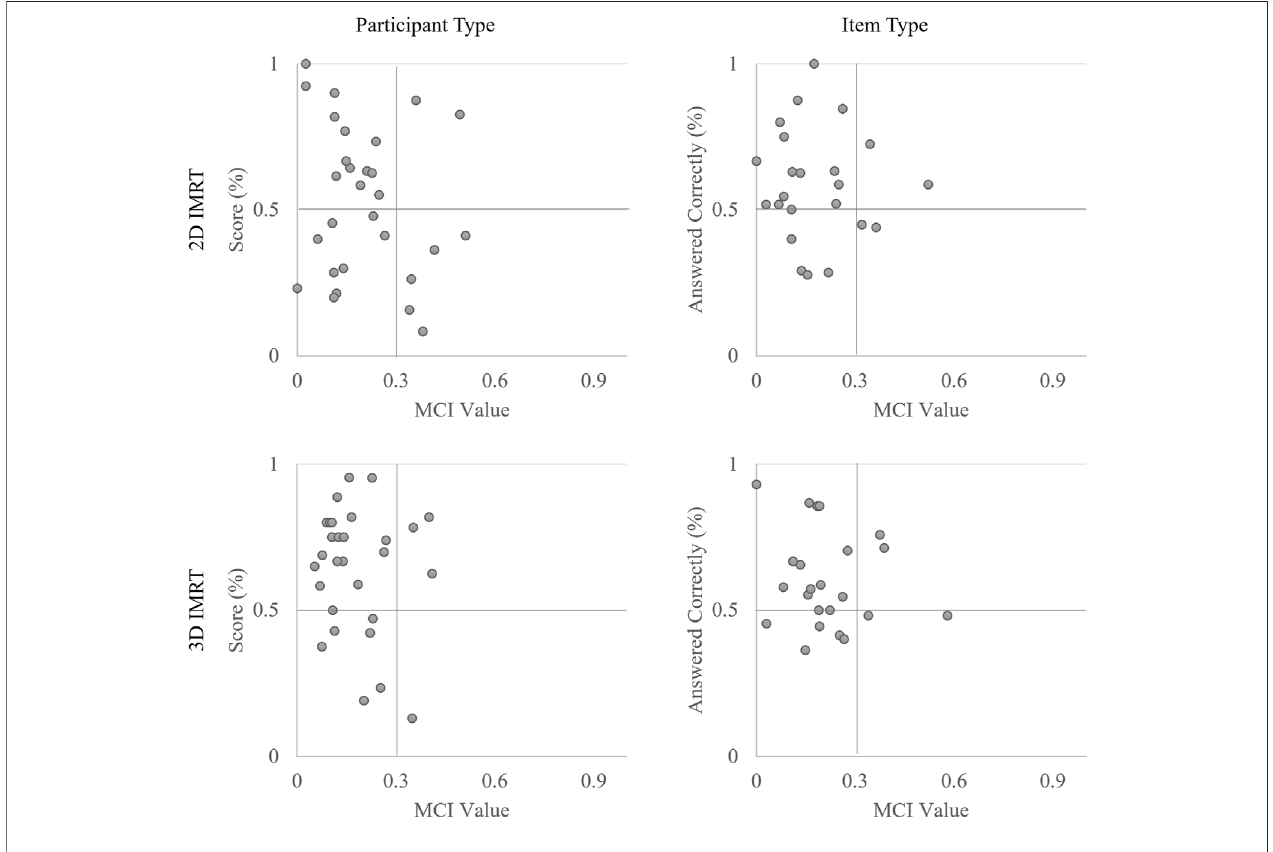
FIGURE 10 | The Participant Type and Item Type charts plot score (questions answered correctly/questions answered) against MCI value to classify student (participant) performance and item (question) dif fi culty. A vertical line at MCI = 0.3 and a horizontal line at score = 0.5 divide the chart into four quadrants. Ideally, all data points should fall in the upper left